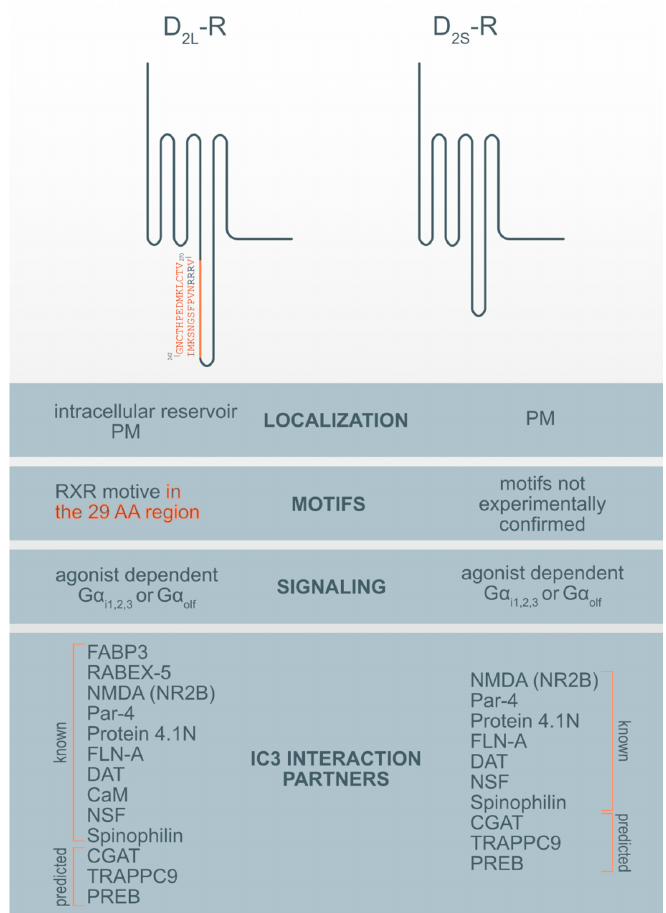
Figure 1. Motif and interaction partners’ differences between D 2L -R and D 2S -R. CaM—Ca 2+ -binding protein calmodulin; CGAT—Chromaffin granule amine transporter; DAT—dopamine transporter; protein calmodulin; CGAT—Chroma ffi n granule amine transporter; DAT—dopamine